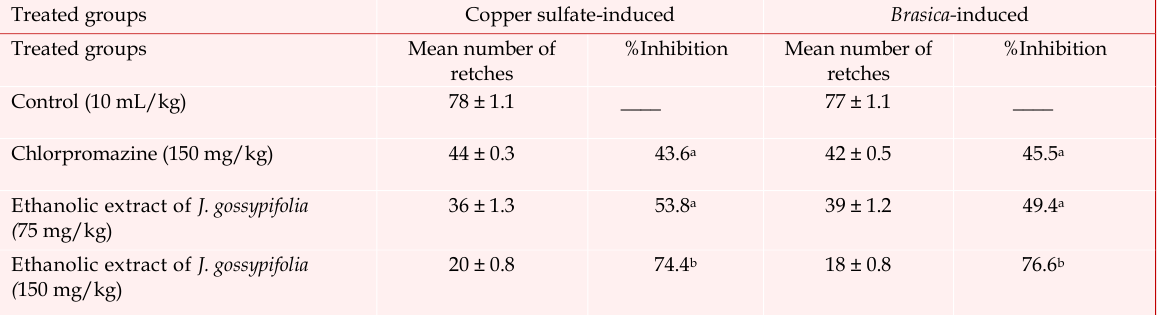
Antiemetic effect of crude extract of J. gossypifolia on copper sulfate and Brasica juice - induced emetic chicks Treated groups Copper sulfate-induced Brasica- induced Treated groups